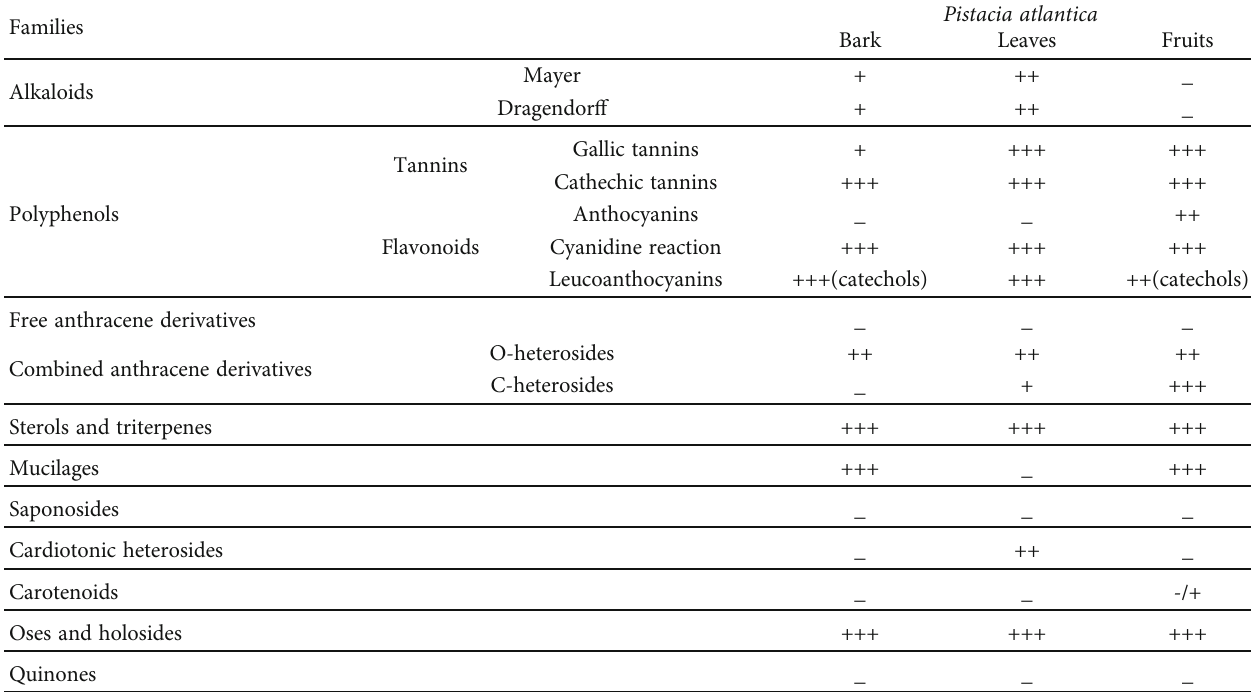
Table 1: Phytochemical screening of the three organs from Pistacia atlantica